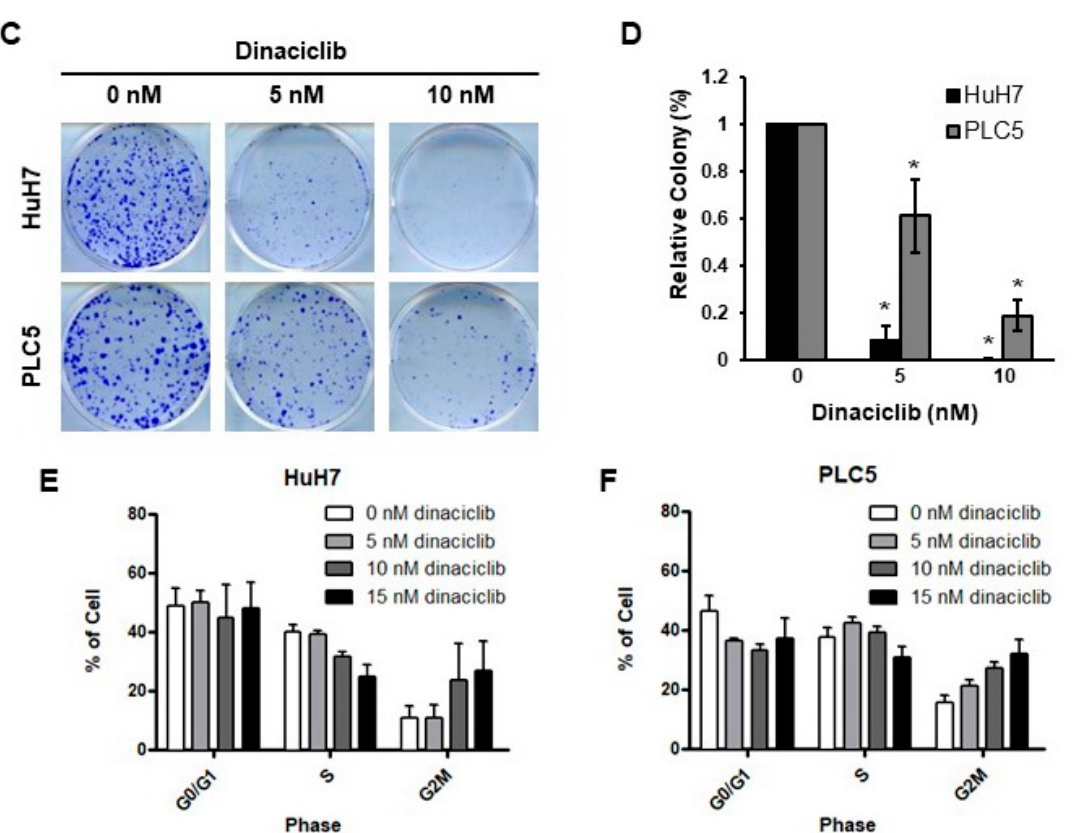
Figure 1. ( A ) MTT assay examining the proliferation of hepatocellular carcinoma (HCC) cell lines after treatment with dinaciclib at the indicated concentration for 72 h. ( B ) Western blot indicating protein expression levels of Rb, phospho-Rb (p-Rb), and c-myc in HCC cell lines. ( C , D ) Colony formation assay. HuH7 and PLC5 cells were seeded in 6-well plates and incubated with dinaciclib at the indicated concentration for 10–14 days (* denotes statistical significance compared to treatment with 0 nM dinaciclib). ( E , F ) Cell cycle assay. HuH7 ( E ) and PLC5 ( F ) cells were treated with dinaciclib at the indicated concentration for 48 h. After being harvested and stained with PI, the cells were counted and classified according their cell cycle phase using flow cytometry.